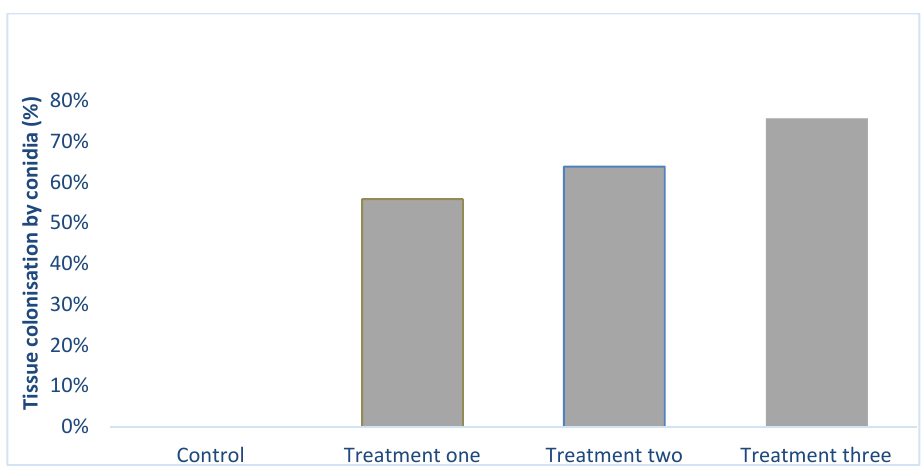
Figure 1. The fungal outgrowth on leaf section of L. sativa following B. bassiana inoculation at different conidia concentrations (Control = 0, treatment one = 1 × 10 6 conidia mL − 1 , 1 × 10 7 conidia mL − 1 and 1 × 10 8 conidia mL − 1 ) ( n = 100). Table 2. The effect of Beauveria bassiana on root length, plant height and crown size of the plants ( Lactuca sativa ) at varying conidial concentrations ( n = 200).